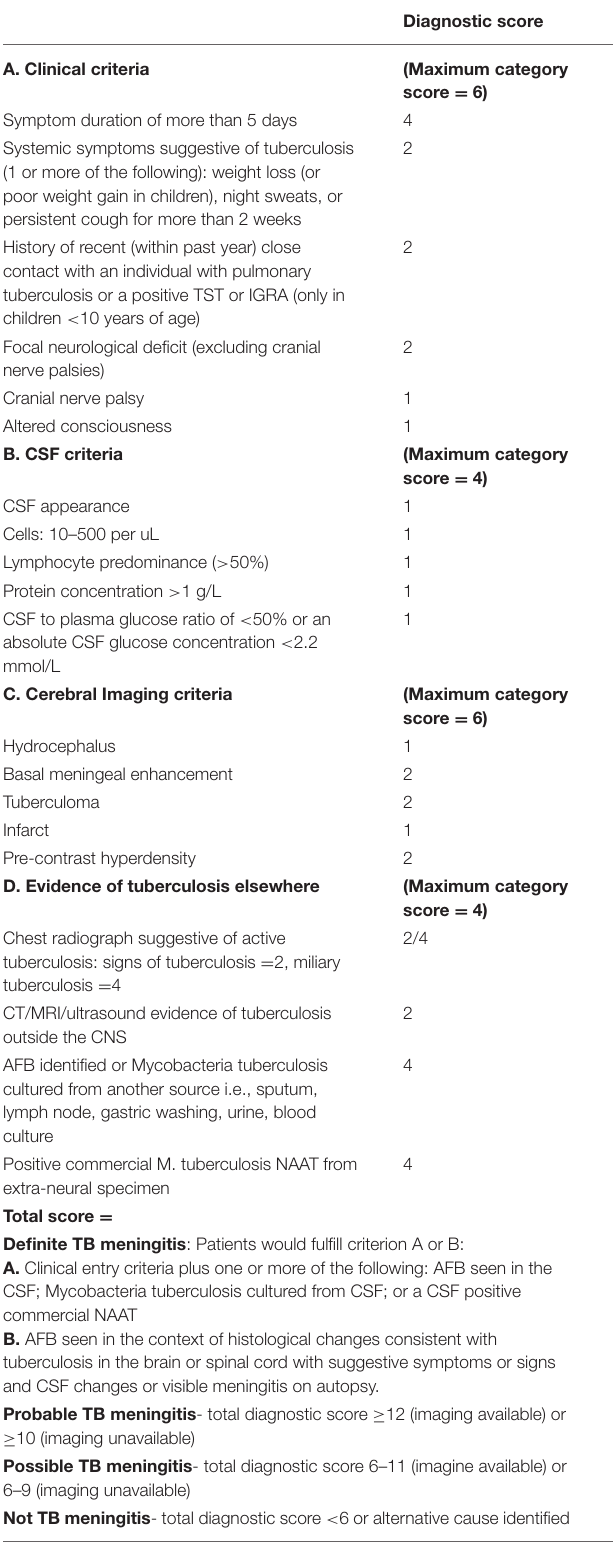
TABLE 1 | Uniform case definition